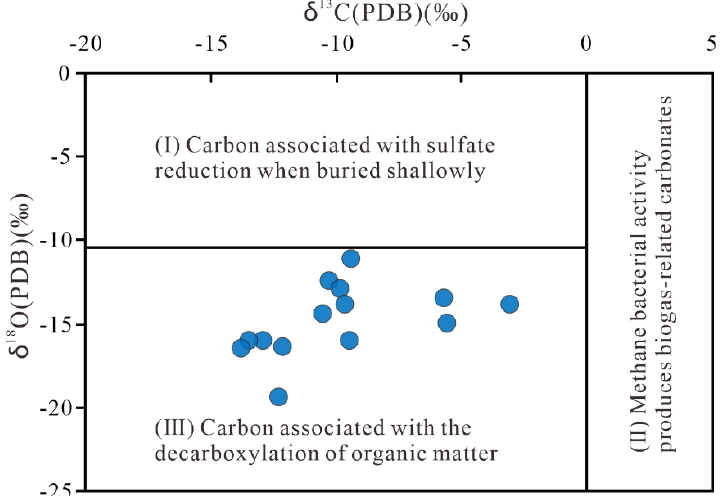
Figure 15. Carbon and oxygen isotopic composition of the calcite cements in the Niudong area (some data from